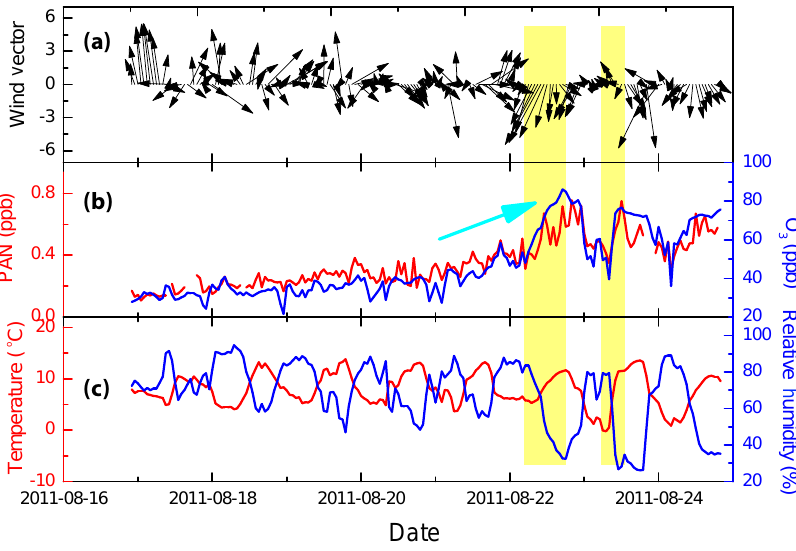
Figure 8. Time series of (a) surface wind vectors, (b) PAN and O 3 , and (c) temperature and relative humidity during 17–24 August 2011. Yellow bars represent the short periods controlled by downward motion. The blue arrow indicates the increasing trend of PAN and O 3